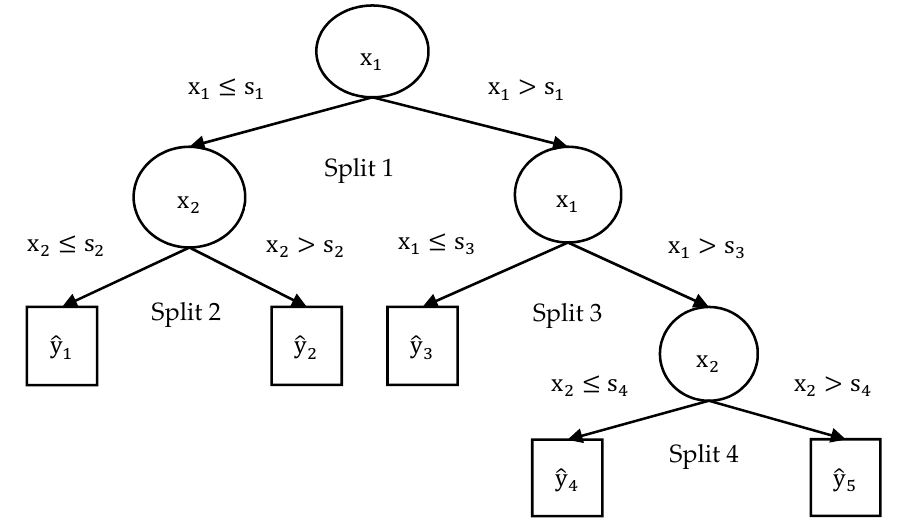
Figure 3. Geometrical representation of regression trees.